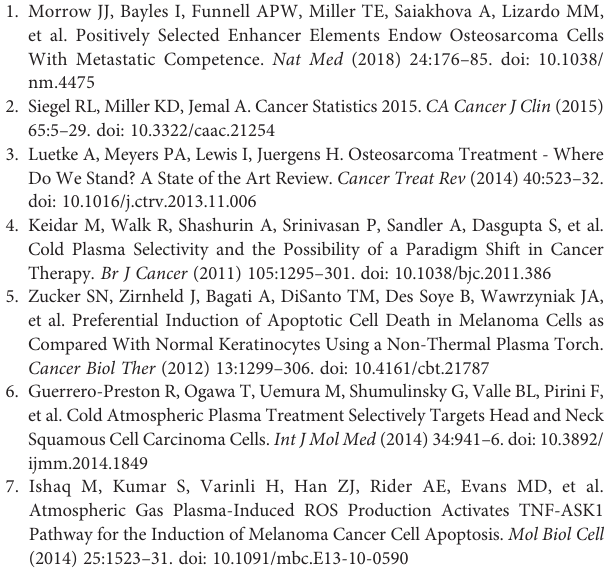
Supplementary Figure 1 | (A) The rate of cell necrosis (Annexin V-negative and 7AAD-positive) of Figure 2C . (B) The rate of cell apoptosis (Annexin V-positive and 7AAD-negative) of Figure2C . Data are the mean ± SD(n = 3). * P < 0.05; ** P < 0.01 vs. control treated with vehicle. Examples of uncropped western blots (C) and quanti fi cation (D) for cleaved caspase 3, cleaved caspase 8, and GAPDH from Figure 2F . Supplementary Figure 2 | Examples of uncropped western blots (A) and quanti fi cation (B) for pRIP-1, pRIP-3, and RIP from Figure 2G . Supplementary Figure 3 | (A) Examples of uncropped western blots for pP70- S6, P70-S6, pRictor, Rictor, pRaptor, Raptor, pP62, P62, LC3 I/II, and GAPDH from Figure 3B . Supplementary Figure 4 | (A) Quanti fi cation of pP70-S6, P70-S6, pRictor, Rictor, pRaptor, Raptor, pP62, P62, LC3 I/II, and GAPDH from Figure 3B . Supplementary Figure 5 | Examples of uncropped western blots (A) and quanti fi cation (B) for pP62, P62 LC3-I/II, and GAPDH from Figure 4A . Supplementary Figure 6 | (A) Cells positive for EthD-1 of Figure 4H were counted and quanti fi ed. Supplementary Figure 7 | (A) Schematic fl owchart diagram showing the experimental design for PAI and Sal treatment of allograft transplants of osteosarcoma cells in mice. LM8 murine osteosarcoma cells (2 × 10 6 cells/mouse) in 0.1 ml DMEM were injected subcutaneously into the back of the mice on day 0. Three times per week after day 7, PAI and Sal alone or in combination were administered intravenously to 6 mice per group. The mice were weighed, and the size of the primary tumors was measured every week. On day 35, all mice were sacri fi ced. (B) Representative photos of tumor-bearing mice at 4 weeks after inoculation of LM8